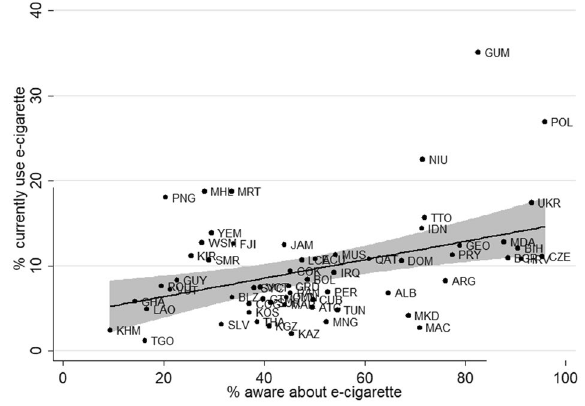
Figure 2. Two-way scatter plots between the prevalence of awareness and current EC use (both sexes) in 61countries. Congo-COG, Ghana-GHA, Mauritania-MRT, Mauritius-MUS, Seychelles-SYC, Togo-TGO, Antigua and Barbuda-ATG, Argentina-ARG, Belize-BLZ, Bolivia-BOL, Cuba-CUB, Dominican republic-DOM, Ecuador-ECU, El Salvador-SLV, Grenada-GRD, Guatemala-GTM, Guyana-GUY, Jamaica-JAM, Panama- PAN, Paraguay-PRY, Peru-PER, Saint Lucia-LCA, Suriname-SUR, Trinidad and Tobago-TTO, Yemen-YEM, Iraq-IRQ,Morocco-MAR,Oman-OMN,Qatar-QAT,Tunisia-TUN,Thailand-THA,Indonesia-IDN,Vanuatu- VUT,Cambodia-KHM, Cook islands-COK, Fiji-FJI, Guam-GUM, Kiribati-KIR, Lao republic-LAO, Macao- MAC, Marshall islands-MHL, Mongolia-MNG, Niue-NIU, Papua new guinea-PNG, Samoa-WSM, Ukraine- UKR, Albania-ALB, Bulgaria-BGR, Croatia-HRV, Czech republic-CZE, Georgia-GEO, Kazakhstan-KAZ, Kosovo-KOS, Kyrgyzstan-KGZ, Macedonia-MKD, Poland-POL, Moldova, Republic of-MDA, Romania-ROU, San Marino-SMR, Bosnia-BIH, Saint Vincent and The Grenadines-VCT. (Spacing after the comma should be consistently